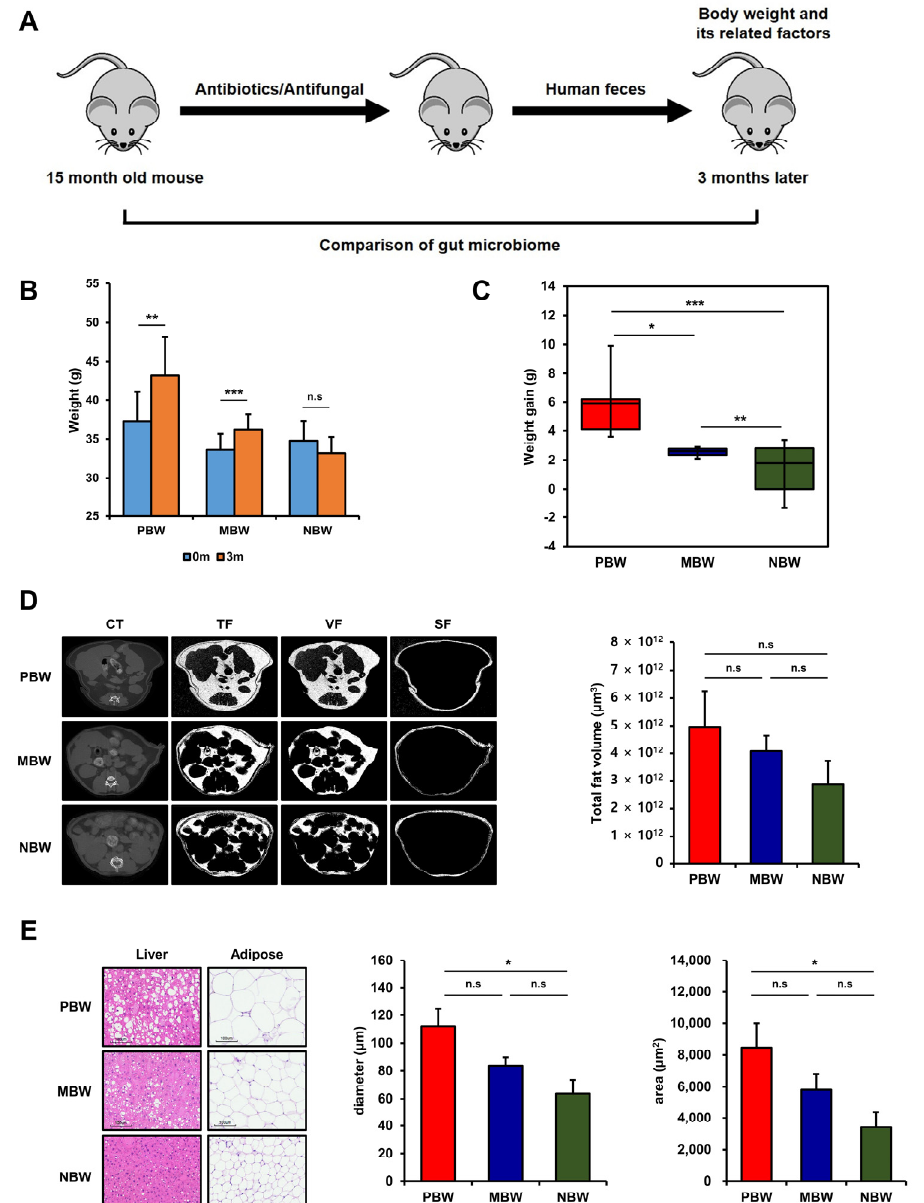
Figure 1. Grouping of mice based on body weight change before and after the intestinal microbiota transplantation. ( A ) The schematic diagram of the experimental strategy. ( B ) The body weight of the experimental mice before and after the gut microbiota replacement. ( C ) The body weight change of the experimental mice between before and after the gut microbiota replacement. ( D ) The representative micro-CT image of PBW, MBW, and NBW used for abdominal fat analysis. ( E ) The representative histological image of the H&E-stained liver and adipose tissue (scale bar, 100 µ m) of PBW, MBW, and NBW. The values represent the mean ± SEM. TF, total fat; VF, visceral fat; SF, subcutaneous fat. * p < 0.05; ** p < 0.01; *** p < 0.001; n.s: not significant ( p >